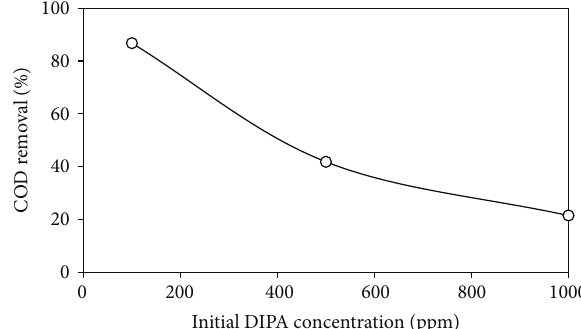
Figure 9: Effect of initial DIPA concentration on % COD removal using Cu-Ni/TiO 2 photocatalysts (photocatalysts loading = 1g ⋅ L −1 ; calcination temperature = 200 ∘ C; DIPA concentration = 100–1000 ppm; irradiation time = 1h).